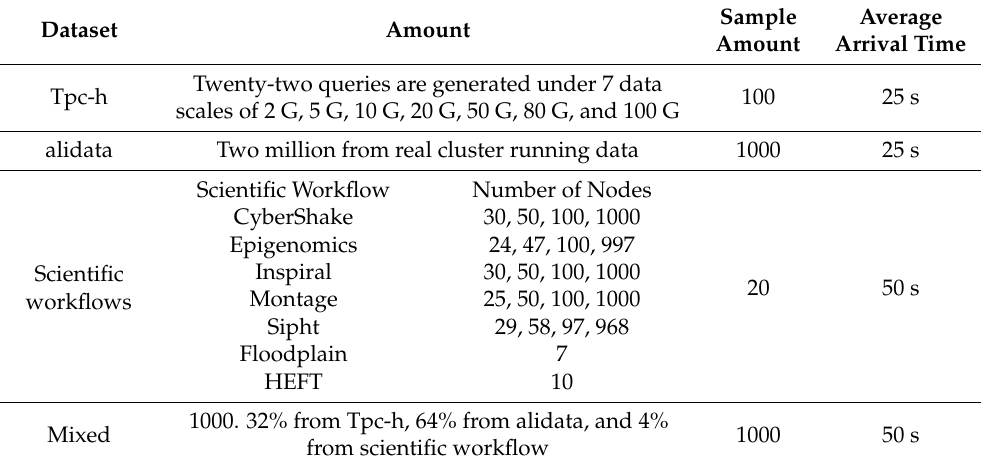
Table 2. Datasets in this paper.